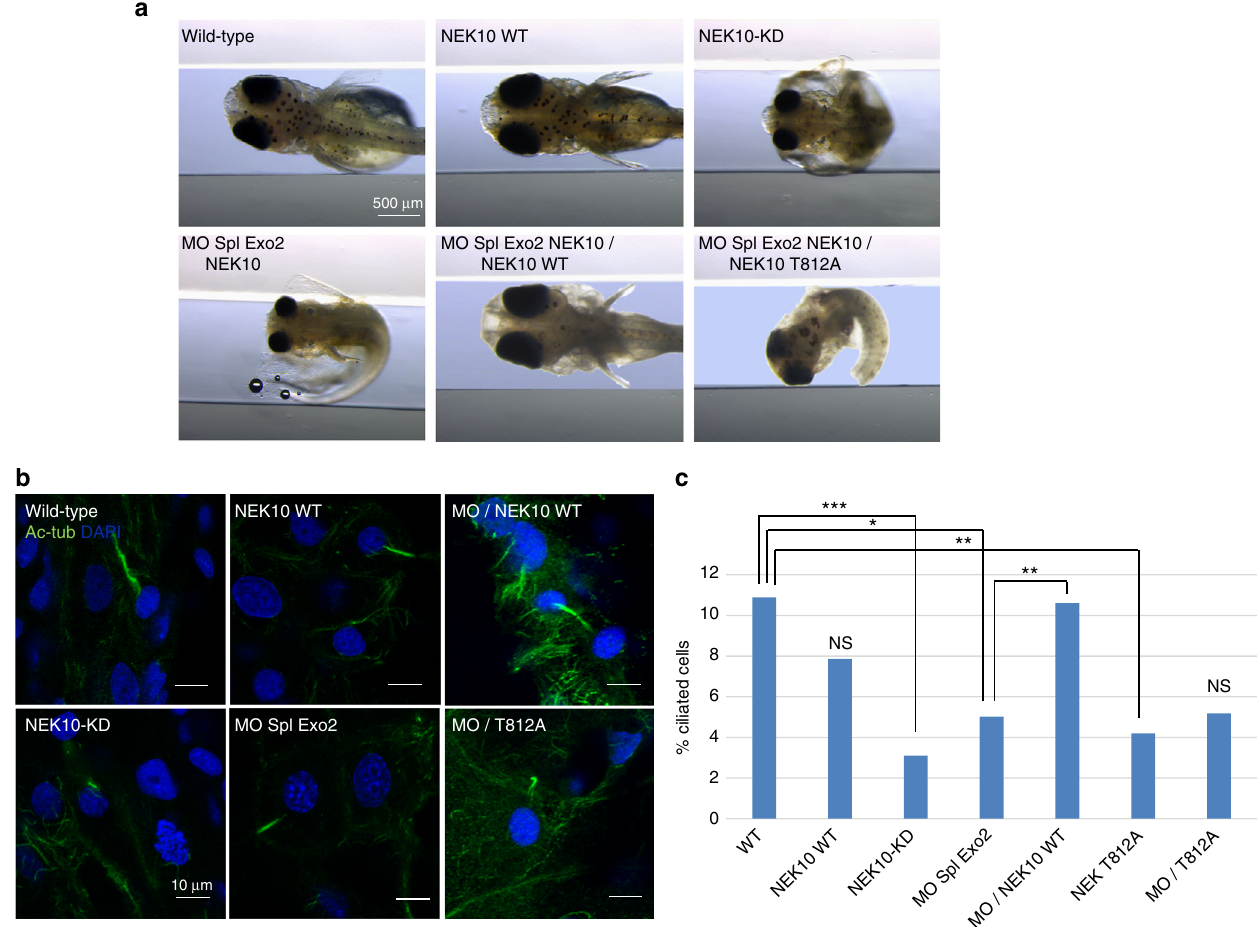
Fig. 5 NEK10 is required for medaka fi sh development. a Stereomicroscopic images of WT, NEK10 WT, NEK10-KD, MO-Spl Exo2 Nek10, MO-Spl Exo2 Nek10/NEK10 WT, and MO-Spl Exo2 Nek10/NEK10-T812A injected Medaka larvae, at stage 40. NEK10 WT injected larvae appear morphological identical to control WT larvae. NEK10-KD and MO Spl Exo2 show morphological alterations (i.e., microphthalmia, microcephaly, curved body, and others), which were all reminiscent of defective cilia phenotypes in medaka cilia mutants. NEK10-WT co-injections with MO-Spl Exo2 NEK10 rescued the morphological phenotype that was observed in MO-Spl Exo2 NEK10 larvae. NEK10-T812A co-injections with MO-Spl Exo2 NEK10 were not able to rescue the morphological phenotype observed in MO-Spl Exo2 NEK10 larvae. b Confocal images of cilia of the neural tube cells in the WT, NEK10 WT, MO-Spl Exo2 NEK10/NEK10 WT, NEK10-KD, MO-Spl Exo2 NEK10, MO-Spl Exo2 NEK10/NEK10-T812A stained with anti-acetylated α -tubulin Ab (green) and DAPI (blue). c In the graph is reported cilium length measurements of WT, WT-NEK10, NEK10-KD, MO-Spl Exo2, MO-Spl Exo2/NEK10 WT, NEK10-T812A, and MO-Spl Exo2/NEK10-T812A embryos (n12) (ANOVA test: *** p < 0.000005; ** p < 0.00005; * p <